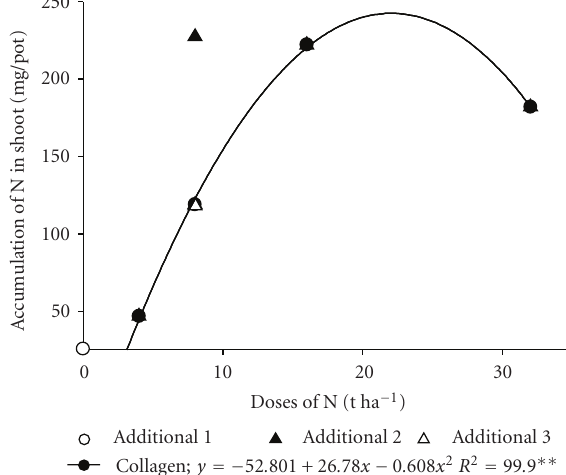
Figure 5: Content of N in the shoot dry matter in bean plants grown for 84 days, under influence of the studied treatments (col- lagen: four rates; additional 1: soil without fertilization and without collagen; additional 2: fertilization with mineral N; additional 3: wet blue residue).